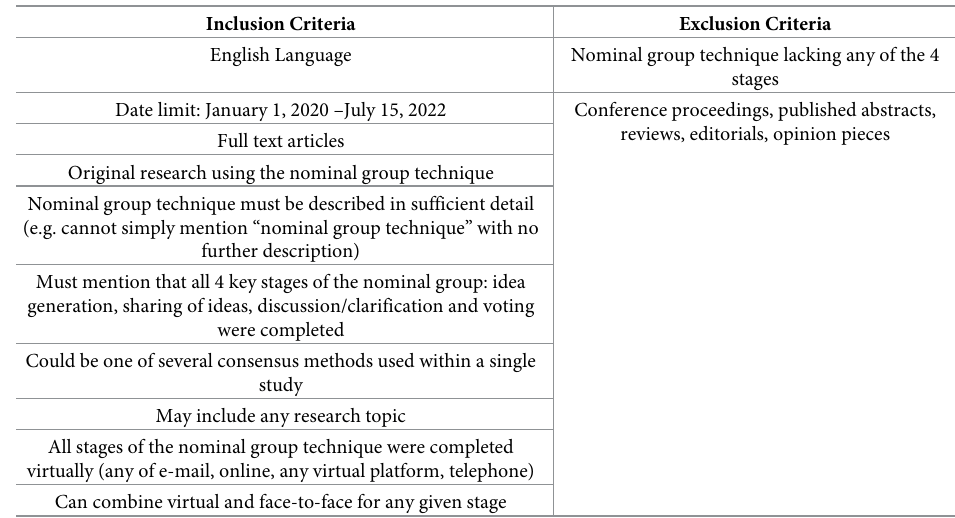
Table 2. Final inclusion and exclusion